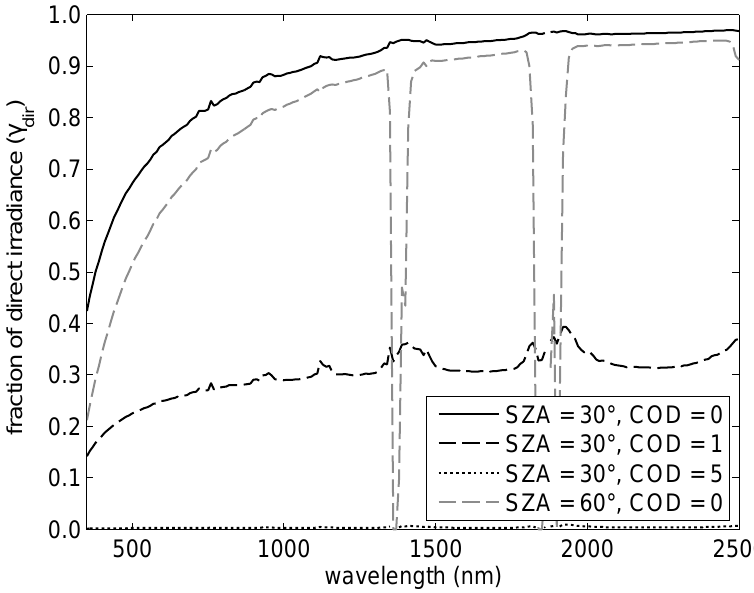
Figure 2. Fraction of direct irradiance for different values of solar zenith angle (SZA) and cloud optical depth (COD) simulated with SBDart. Simulations used fixed values for atmo- sphere optical depth (0.3), cloud altitude (4,000–4,400 m), water vapor content ( 2 . 5 g cm − 2 ) and ozone content ( 0 . 3 atm cm − 1